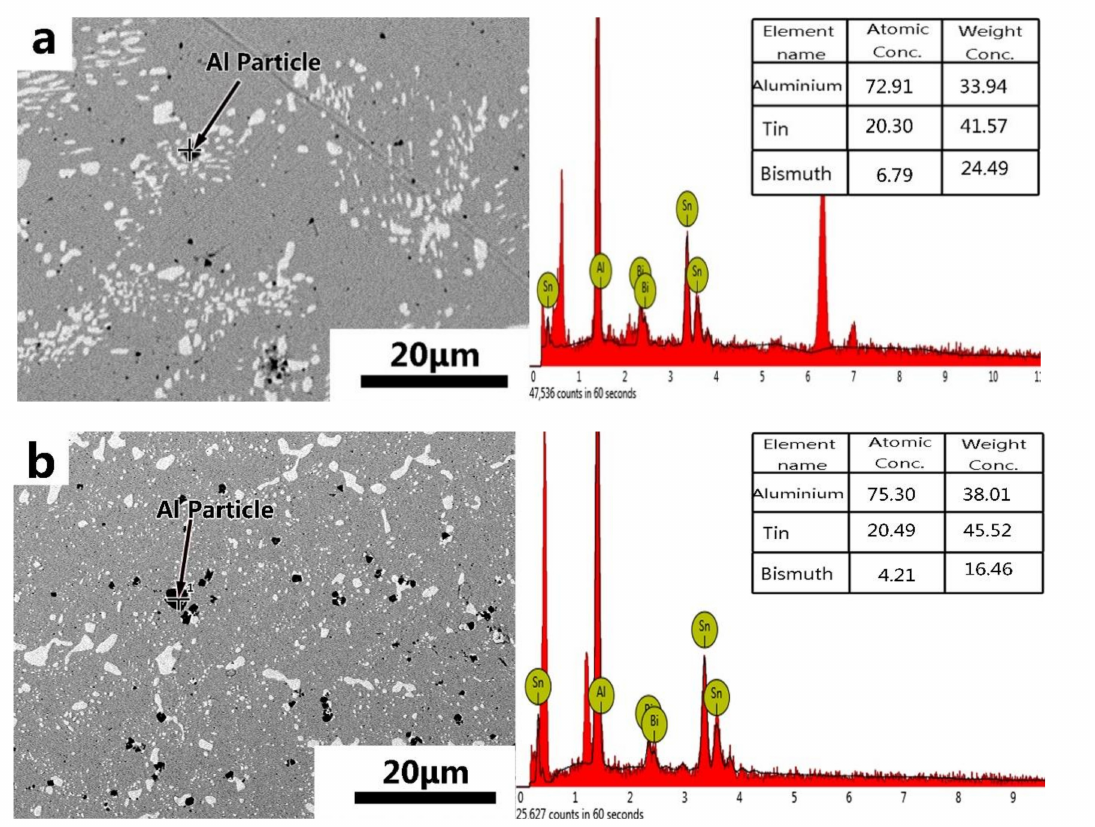
Figure 3. Energy dispersive spectroscopy (EDS) results of the third phase in ( a ) Sn-20Bi-0.3Al and ( b ) Sn-20Bi-0.5Al solder